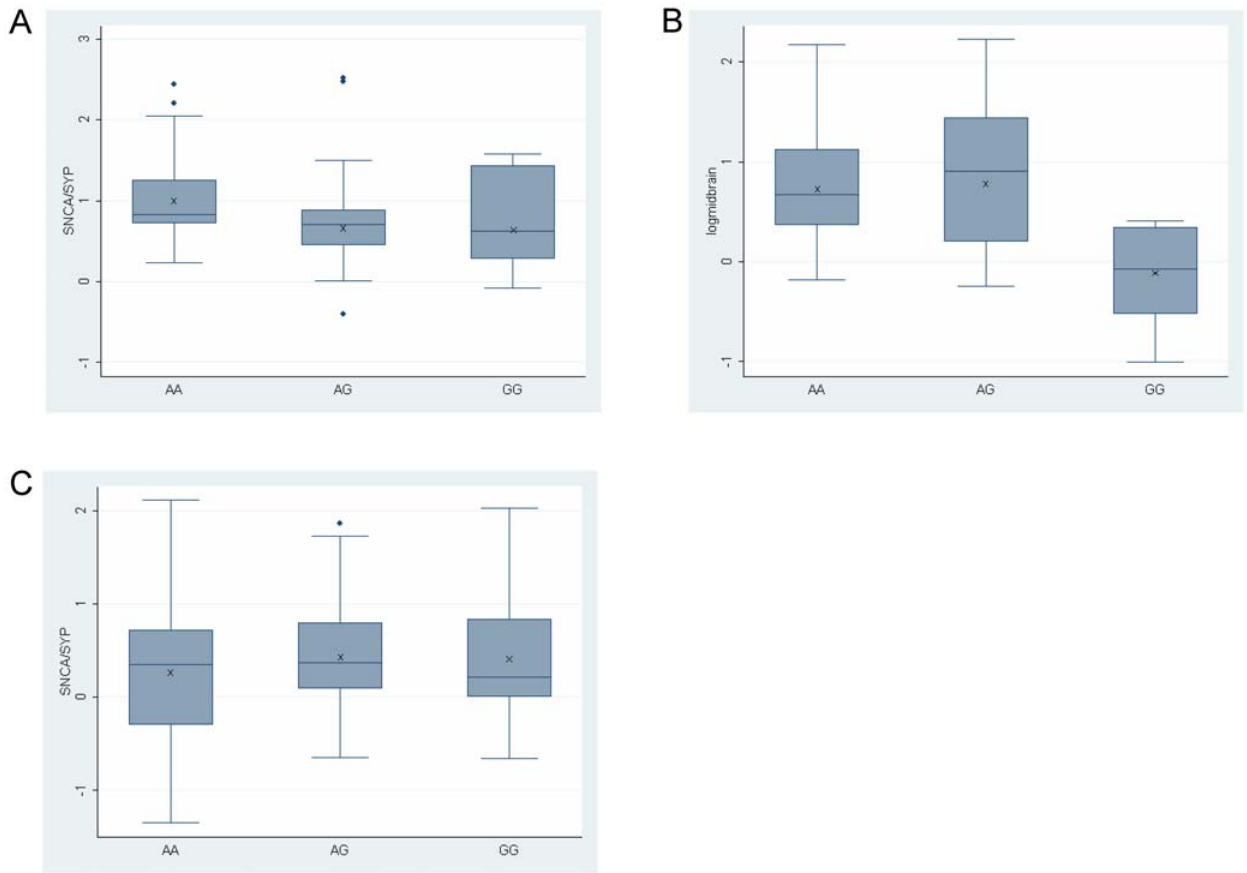
Figure 4. Effect of SNP rs356219, 3 9 region genotypes, on human SNCA -mRNA expression levels in human brains. Individuals were genotyped for SNP rs356219. Three brain regions were analyzed: temporal cortex ( A ), midbrain including SN ( B ) and frontal cortex ( C ). In each brain region fold levels of human SNCA -mRNA were assayed by real-time RT-PCR using TaqMan technology and calculated relative to human SYP -mRNA reference control using the 2 - D Ct method. (A) Analysis of the temporal cortex showed that the protective genotype AA correlates with higher SNCA - mRNA levels than the GA and GG genotypes (P=0.013). The association trend was confirmed in a subset of samples using also the GAPDH and ENO2 reference genes (Table S2). (B) In the midbrain including SN the AA and AG genotypes correlate with higher SNCA-mRNA levels compared with the GG risk genotype (P , 0.05). (C) No correlations of SNP rs356219 genotypes with SNCA -mRNA levels were detected in the frontal cortex. For each genotype the box plot represents the analysis performed using all brain samples available from the specific brain region, each of which was analyzed twice independently, each time in duplicate. The average values are presented in ‘X’. The box plot shows the median (horizontal line inside the box) and the 25 th and 75 th percentiles (horizontal borders of the box). The range between the 25th and 75th percentiles is the interquartile-range (IQR). The whiskers show the minimal and maximal values inside the main data body.